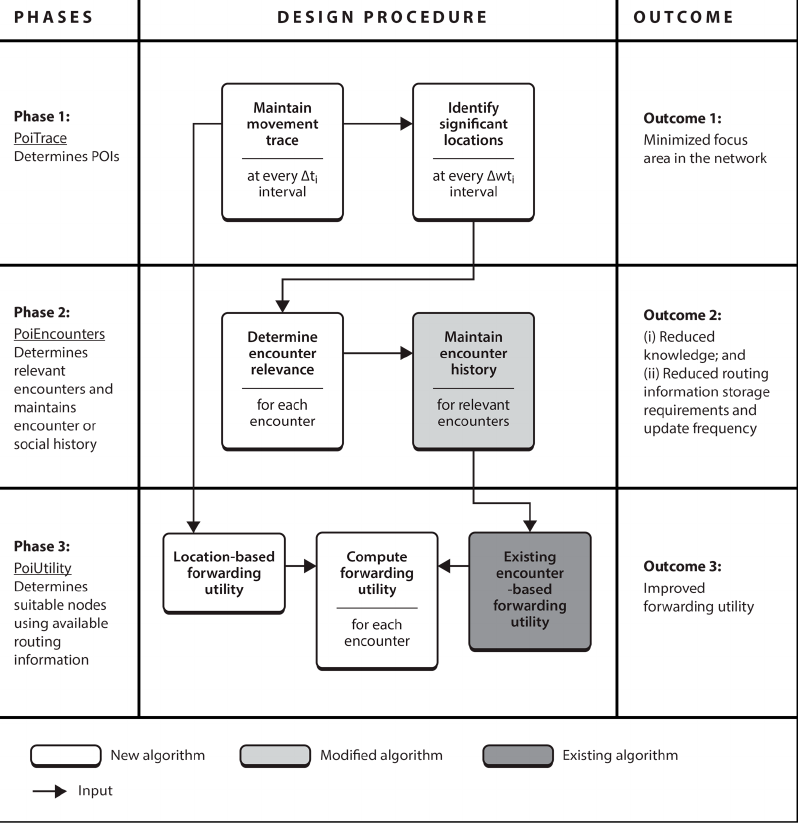
Figure 1. Functional block diagram of PoiFord.